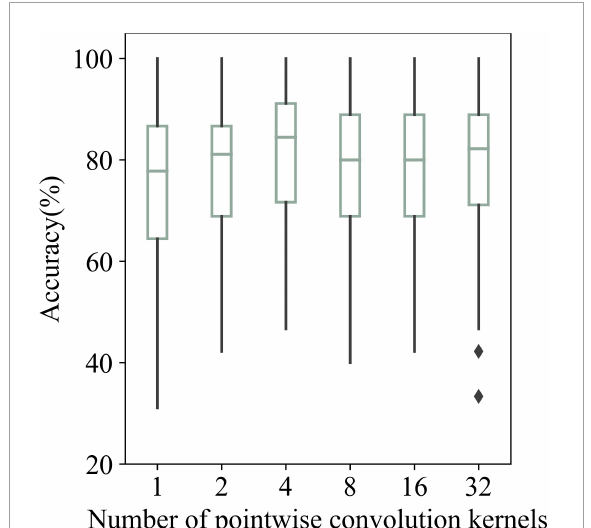
FIGURE11 Recognition accuracies of AR–P300 for all participants with different numbers of pointwise convolution kernels.